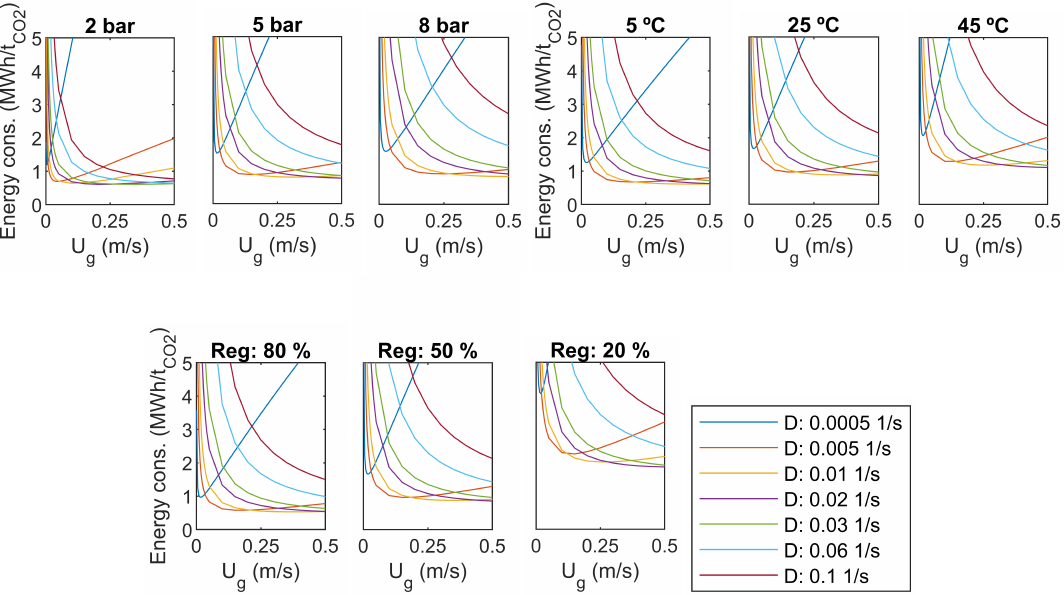
Figure 8. Specific energy consumption, sensitivity to pressure, temperature, and regeneration